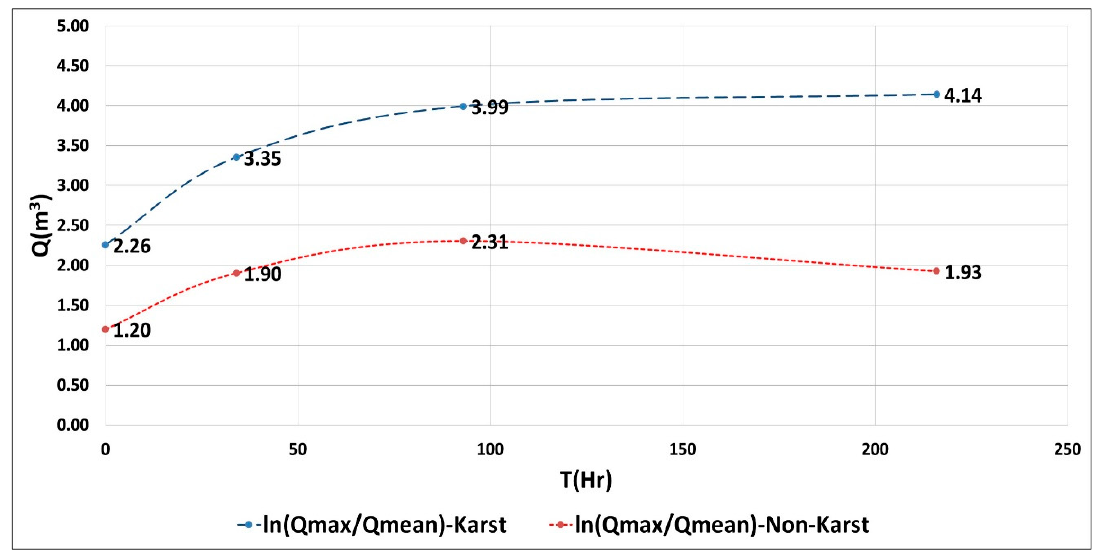
Figure 10. Variability discharge ratio ln(Q max /Q mean ) showing higher discharge rates with respect to time in karst watershed.